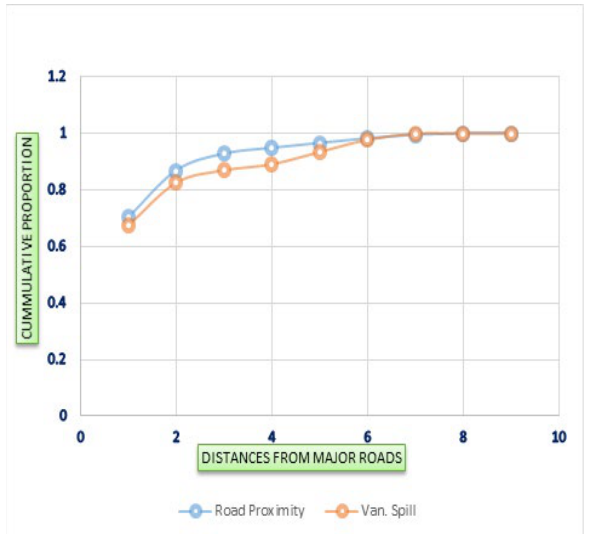
Figure 12. Proximity from vandalization points to the